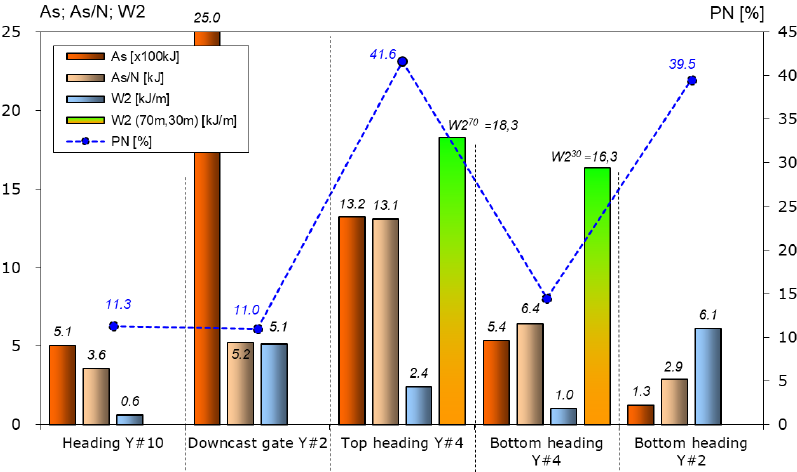
Top heading Y#4 (the initial segment ~70 m in length, in the southward direction), the forecasted maximal vertical stress value ( σ zmax ) 38.7 MPa (stress concentration factor k max = 1.65); Bottom heading Y#4 (the final segment ~25 m in length, in the northward direction and the initial part ~5 m in length, in the southward direction), the forecasted Bottom heading Y#2 (the initial fragment ~20 m in length, driven in the southward centration factor k max = 1.62).